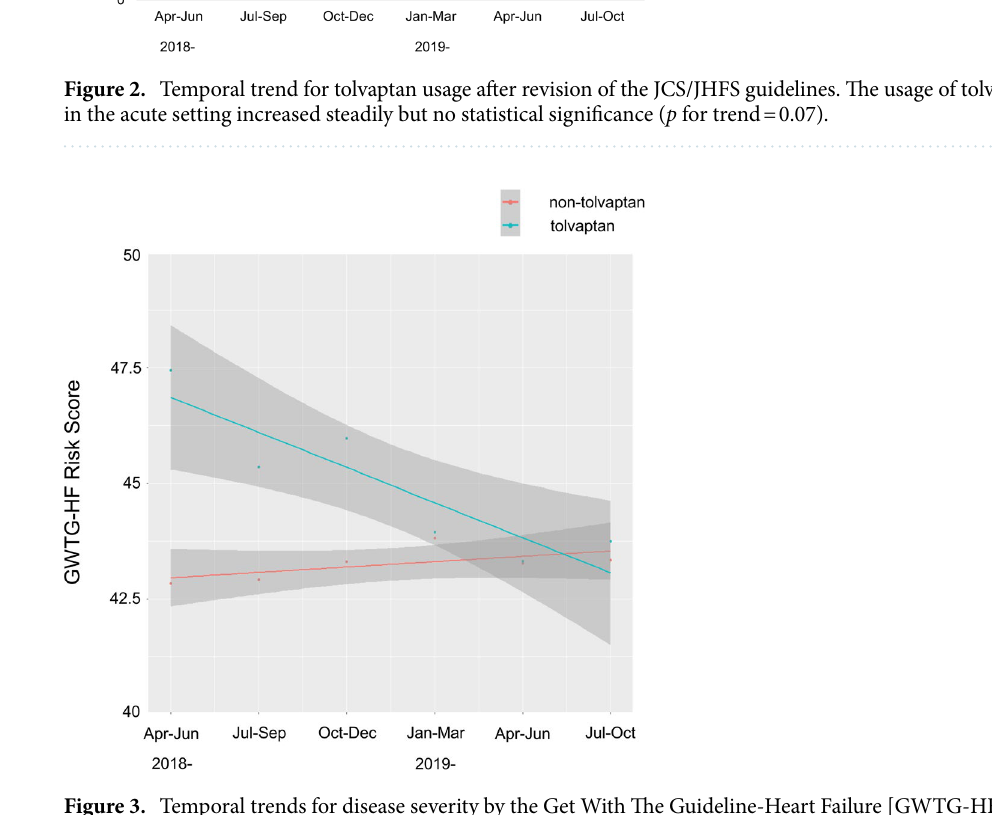
Figure 3. Temporal trends for disease severity by the Get With The Guideline-Heart Failure [GWTG-HF] risk score. The GWTG-HF risk score in the tolvaptan group significantly decreased from 47 to 41 ( p for trend = 0.015), while that in the non-tolvaptan group remained